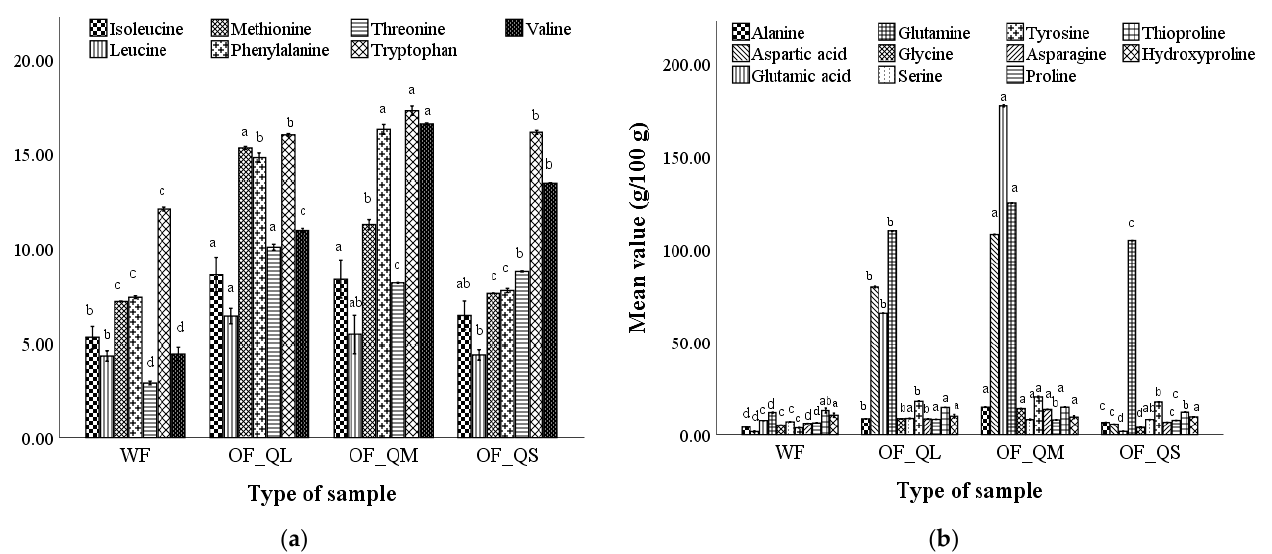
Figure 2. Essential ( a ) and non-essential ( b ) amino acid content of optimal wheat–quinoa composite flour corresponding to large, medium, and small particle size (OF_QL, OF_QM, and OF_QS) vs. wheat flour (WF). Mean values followed by different letters (a–d) are significantly different ( p < 0.05).